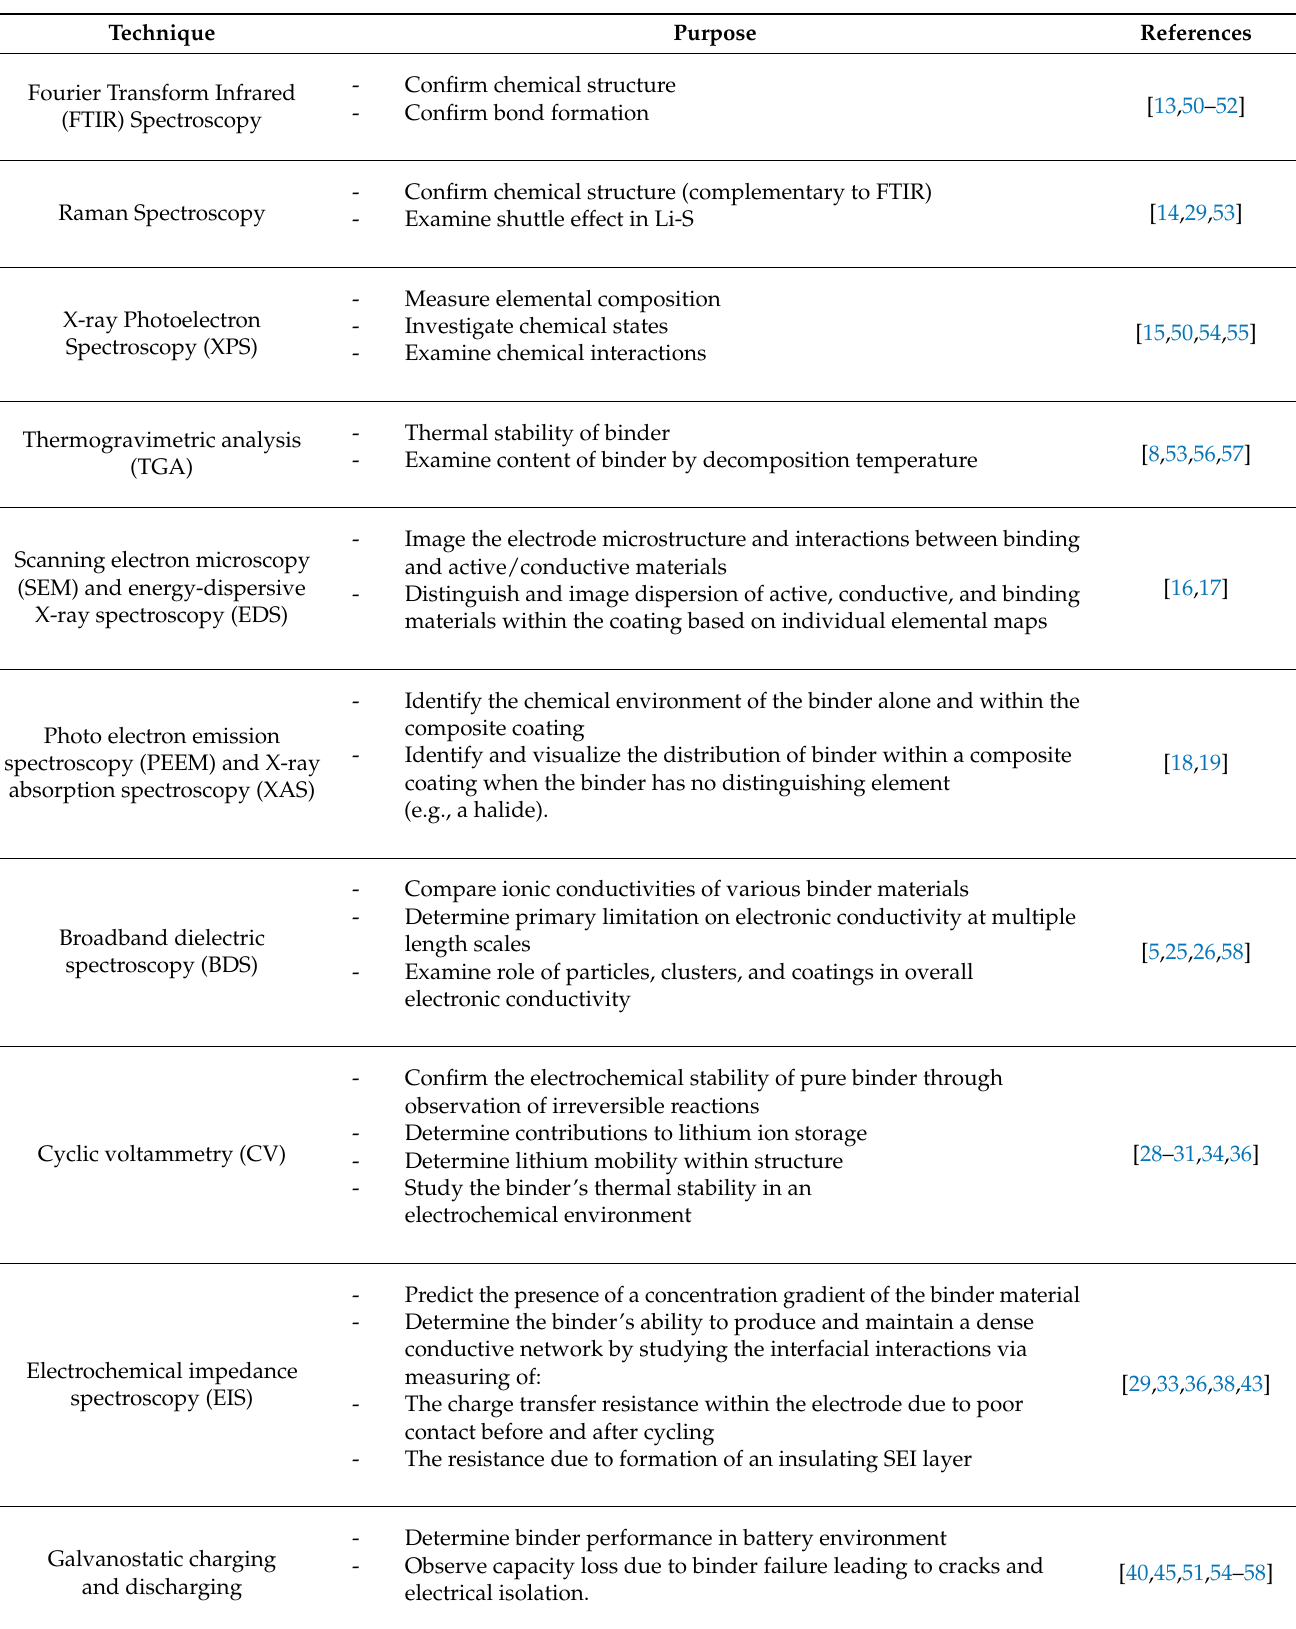
Table 1. Common techniques for characterizing polymer